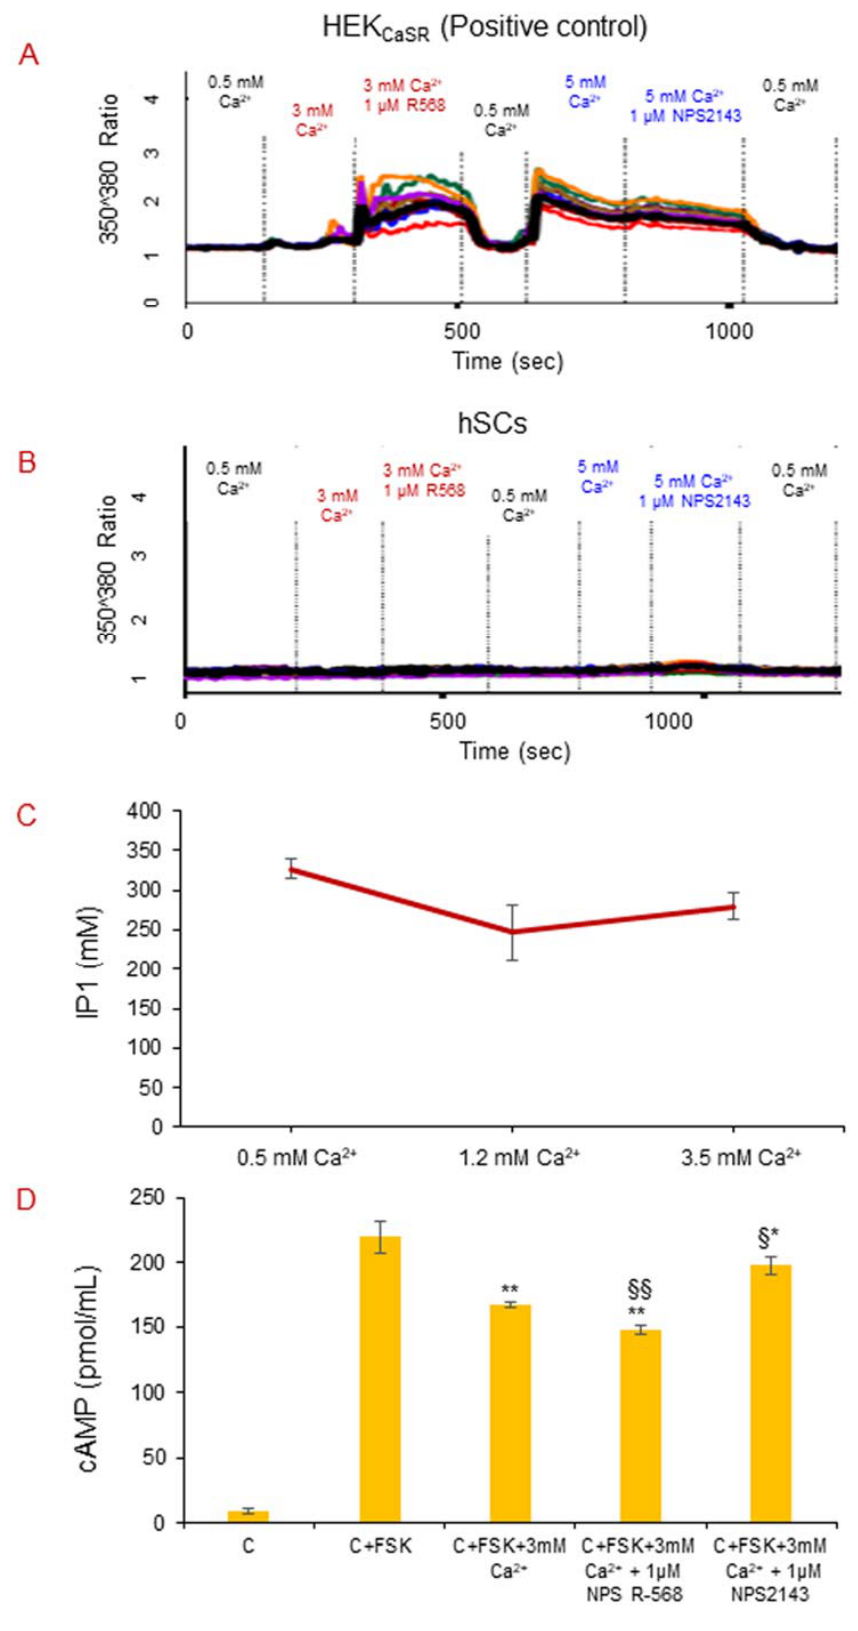
Figure 8. Intracellular calcium mobilization assay with Fura2-AM dye. Graphs representing the effect of CaSR stimulations on intracellular calcium mobilization in HEK CaSR ( A ) used as